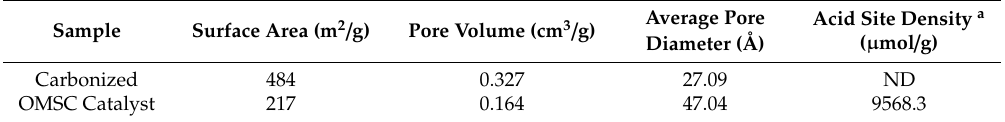
Table 2. Textural property and acid site density of the OMSC catalyst.